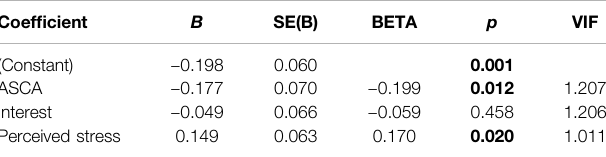
TABLE 4 | Pearson correlation coef fi cients r between objective and subjective measures of cognitive load and task performance for the total sample.